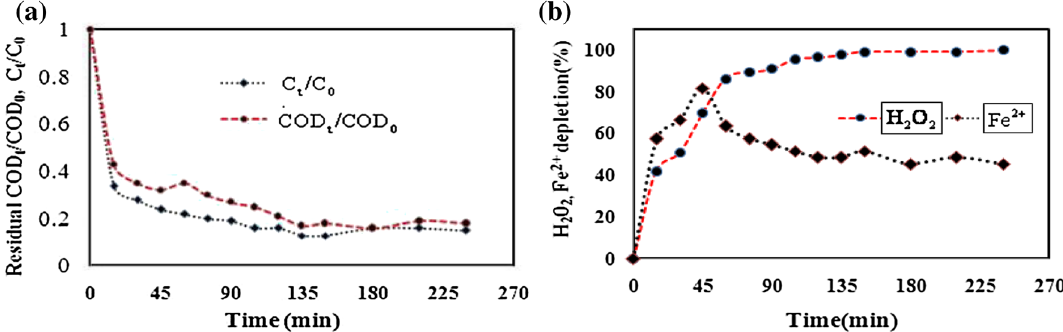
Fig. 3 a Residual COD t /COD 0 and C t /C 0 with reaction time, where COD t = final COD at time t min; COD 0 = initial COD at time 0 min; C t = final concentration at time t min; C 0 = initial